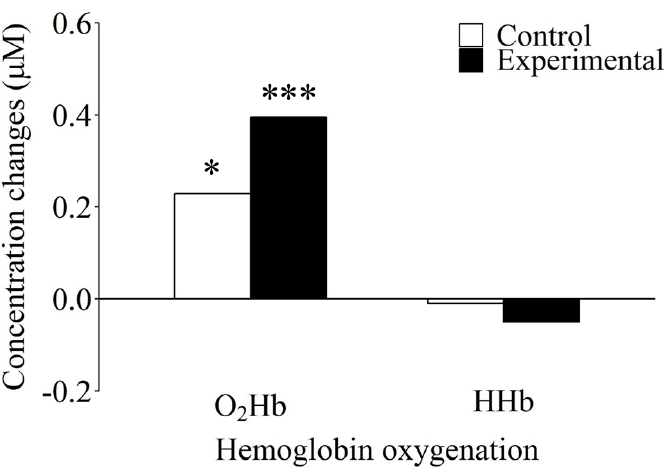
Figure 3. Differences in concentration changes for oxygenated (O 2 Hb) and deoxygenated (HHb) hemoglobin as a function of condition for the working memory task. Within the control and the experimental condition, there was a significant difference in concentration change between O 2 Hb and HHb. *: significantly different from HHb concentration change in the active control condition ( p < 0.05). ***: significantly different from HHb concentration change in the experimental condition ( p < 0.001).